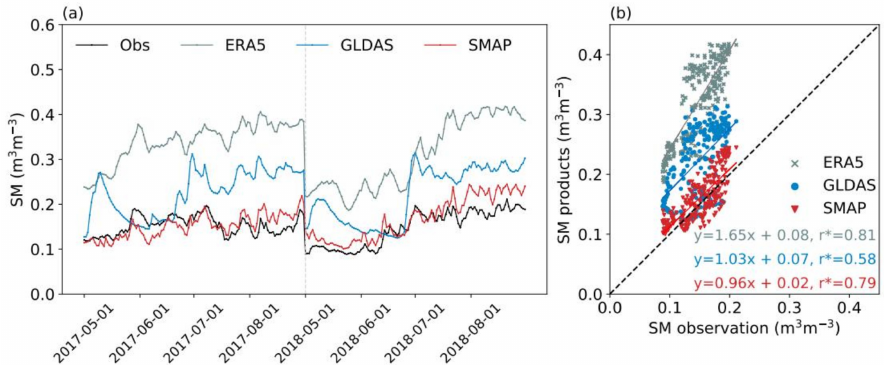
Figure 5. Soil moisture ( a ) time series and ( b ) scatterplot for three soil moisture products and In Situ observations for May to August in 2017 and 2018. * represents the Pearson correlation coefficient (r) is statistically significant at the 95% confidence level according to Student’s t